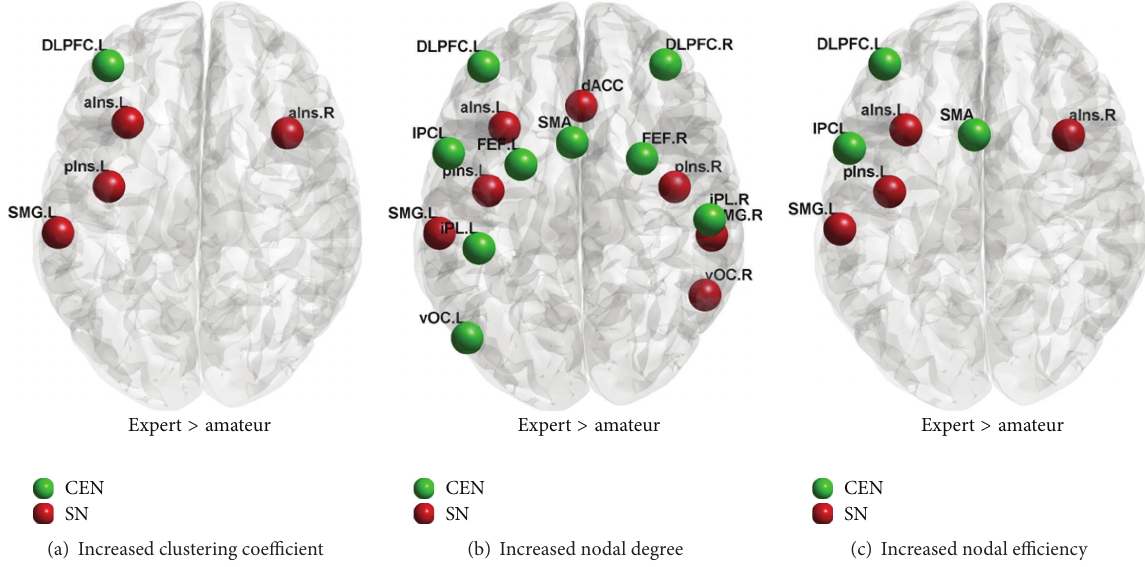
Figure 2: Increased nodal characteristics in the experts over the amateurs. (a), (b), and (c) indicate significantly increased nodal clustering coefficient, degree, and efficiency, respectively. Green dots are the nodes of CEN, while red dots are the nodes of SN.